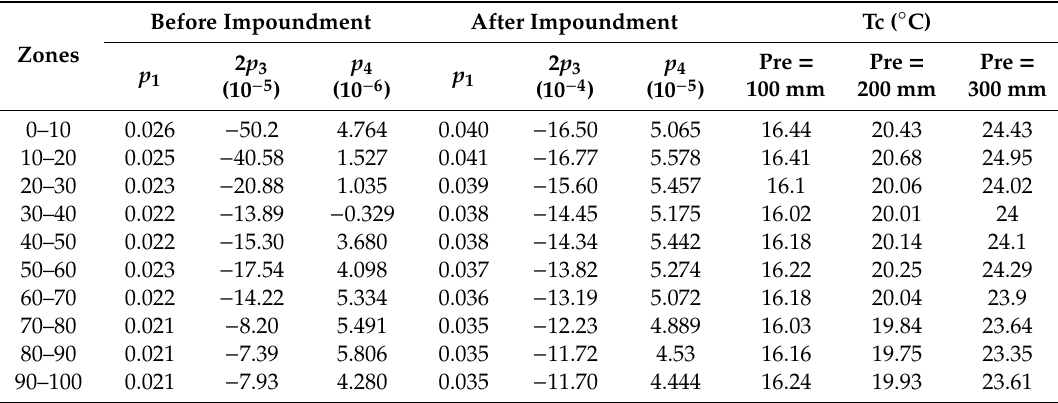
Table 5. SI of NDVI–temperature and temperature